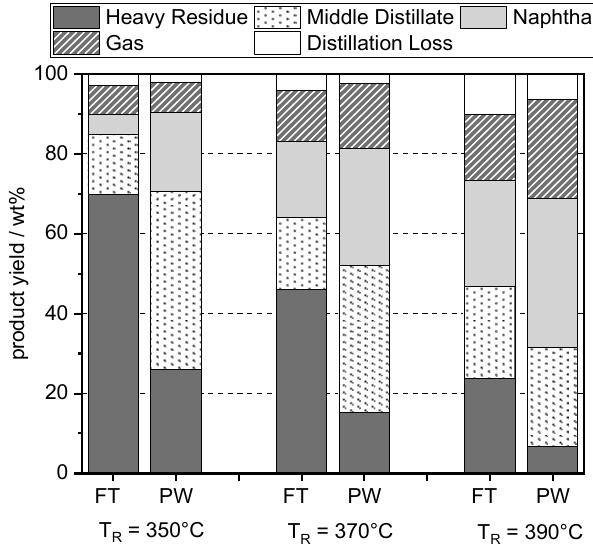
Figure 7. Comparison of product yields after HP of FTW and PW.